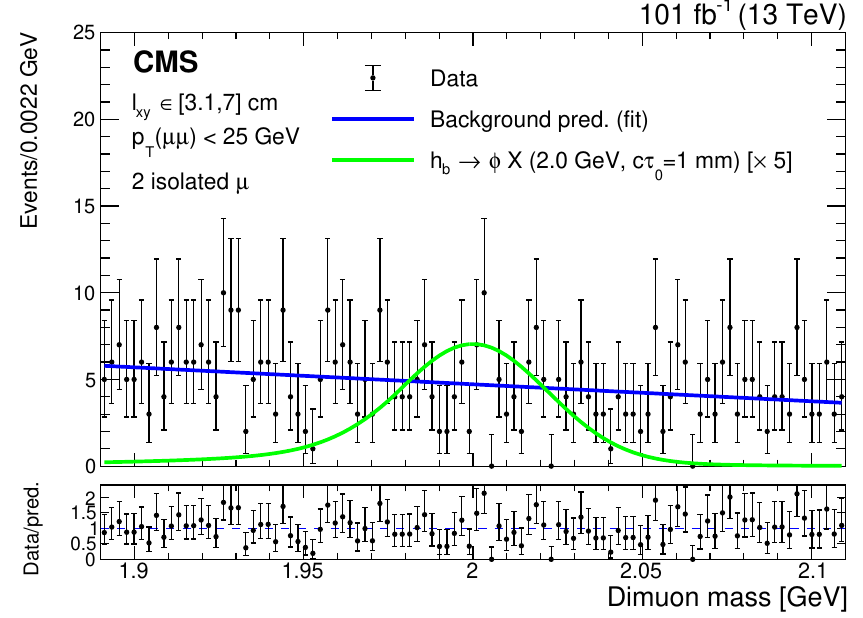
Figure 5 . The dimuon invariant mass distribution is shown in a mass window around 2 GeV, in one of the dimuon search bins ( 3 . 1 ≤ l < 7 . 0 cm, p mm < 25 GeV, with two isolated muons). The xy T result of the background-only fit to the data is also shown (blue) together with the dimuon invariant mass distribution expected for a representative h = 2 GeV → φX signal model (green) with m b φ and cτ φ = 1 mm. The signal event yield corresponds to a value of the branching fraction product 0 B ( h → φX ) B ( φ → µµ ) = 1 . 2 × 10 − 8 , equal to the median expected exclusion limit at 95% CL b set in this paper (see section 7), and is multiplied by a factor of 5 for display purposes. The lower panel shows the ratio of the data to the background prediction, with error bars corresponding to the statistical uncertainty in the